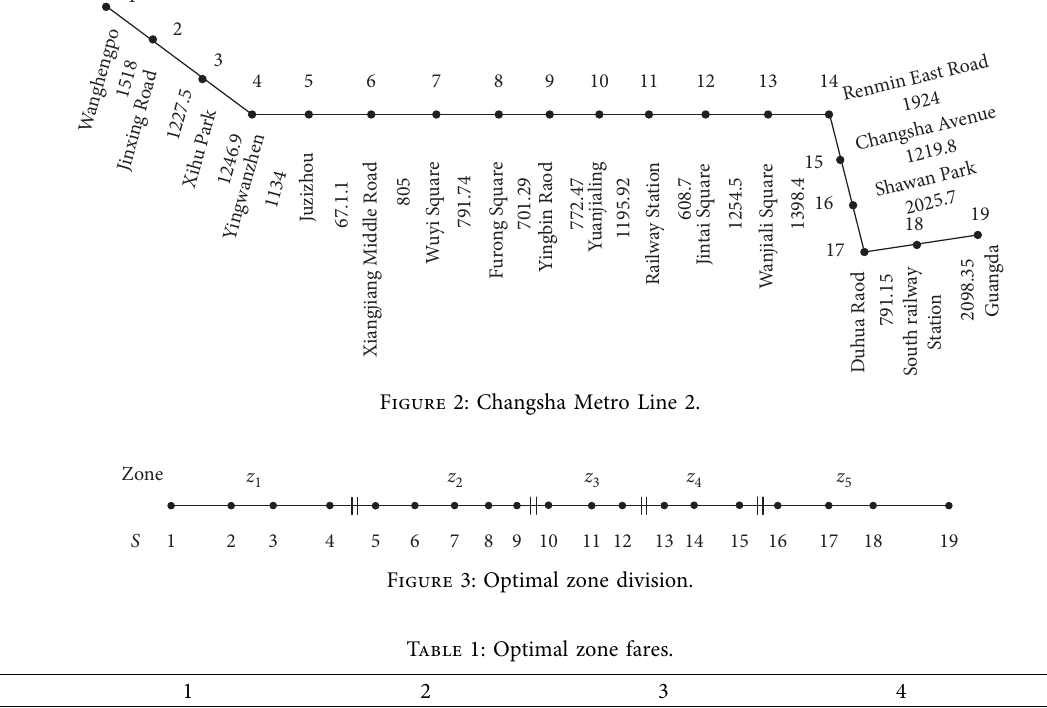
Figure 3: Optimal zone division. Table 1: Optimal zone fares.